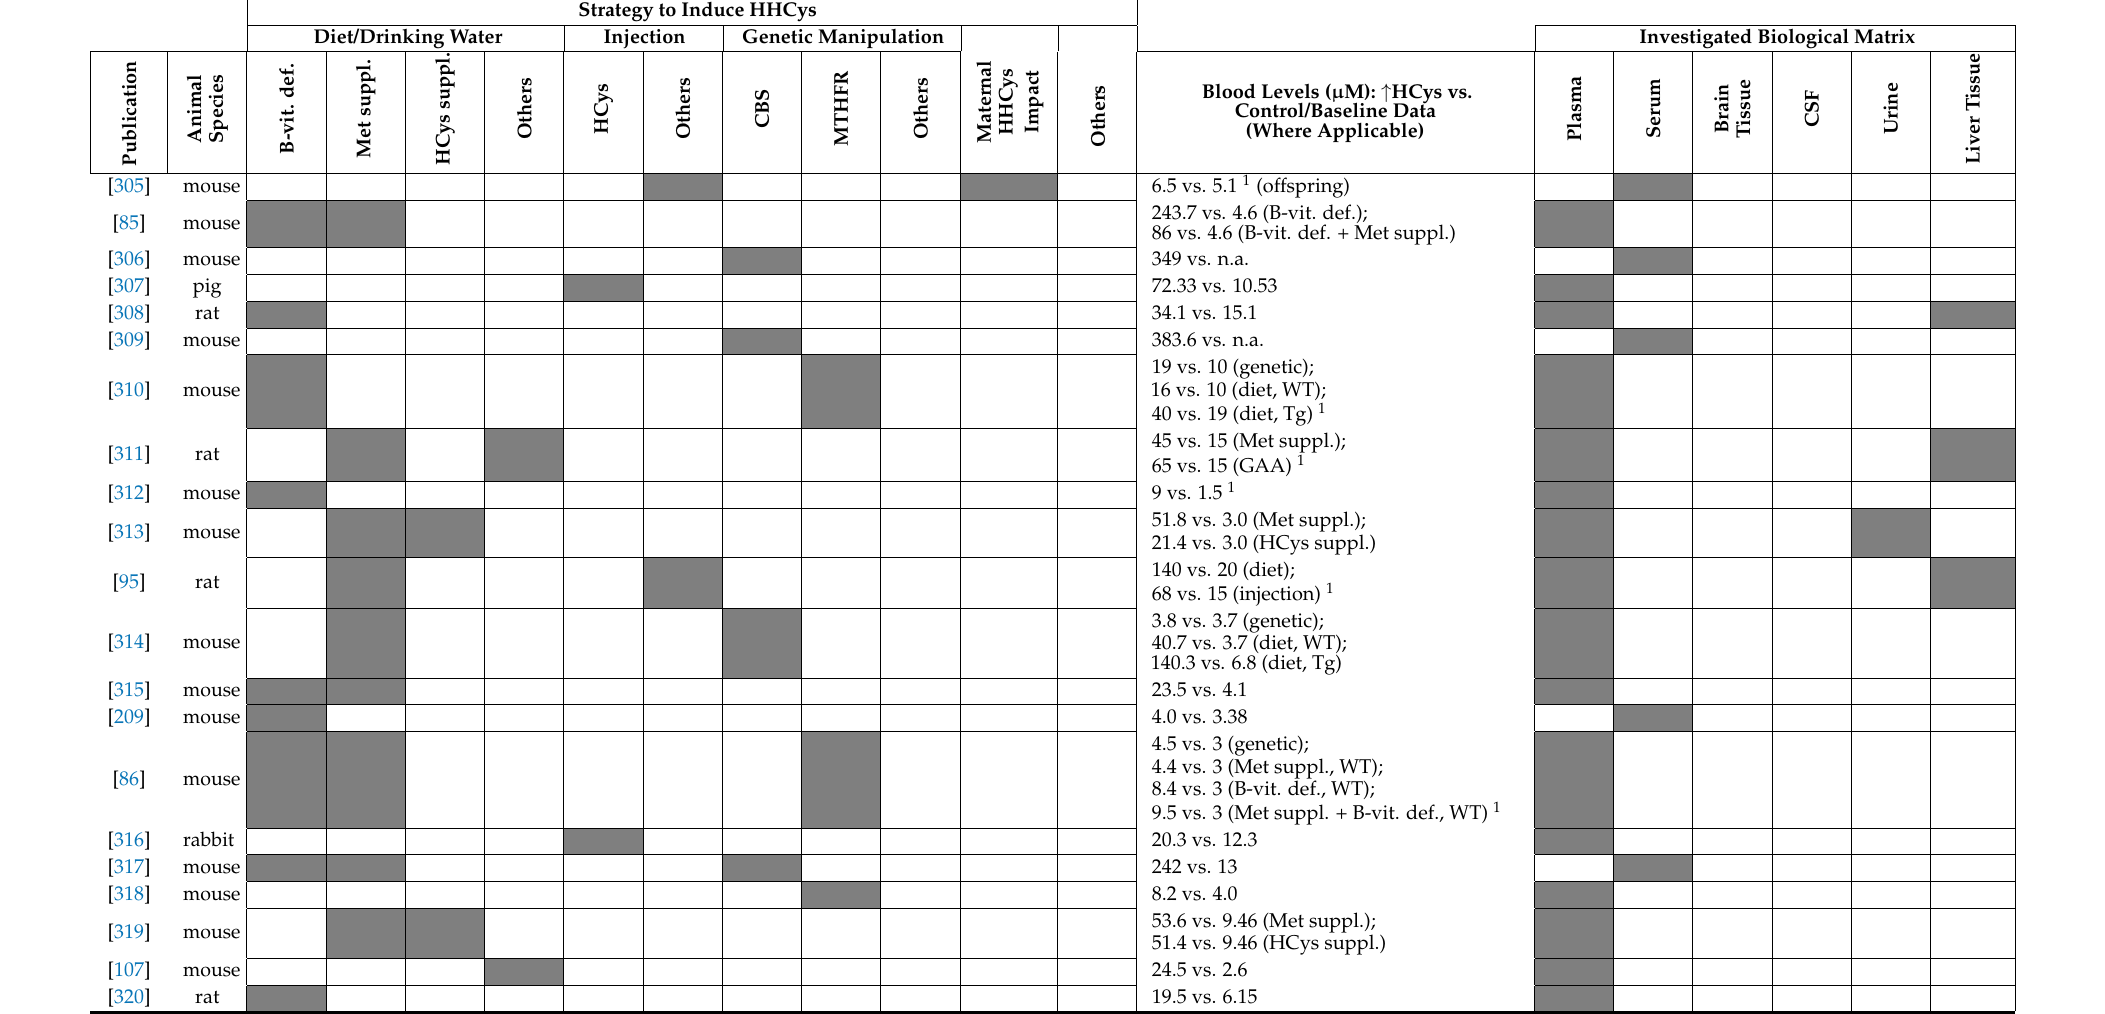
Table A14. Additional hand-searched animal studies; abbreviations: WT: wild type, Tg: transgenic, B-vit. def.: deficiency in B-vitamins (and related substances), Met suppl.: supplementation of L-methionine, CBS: cystathionine β -synthase, MTHFR: methylenetetrahydrofolate reductase, GAA: